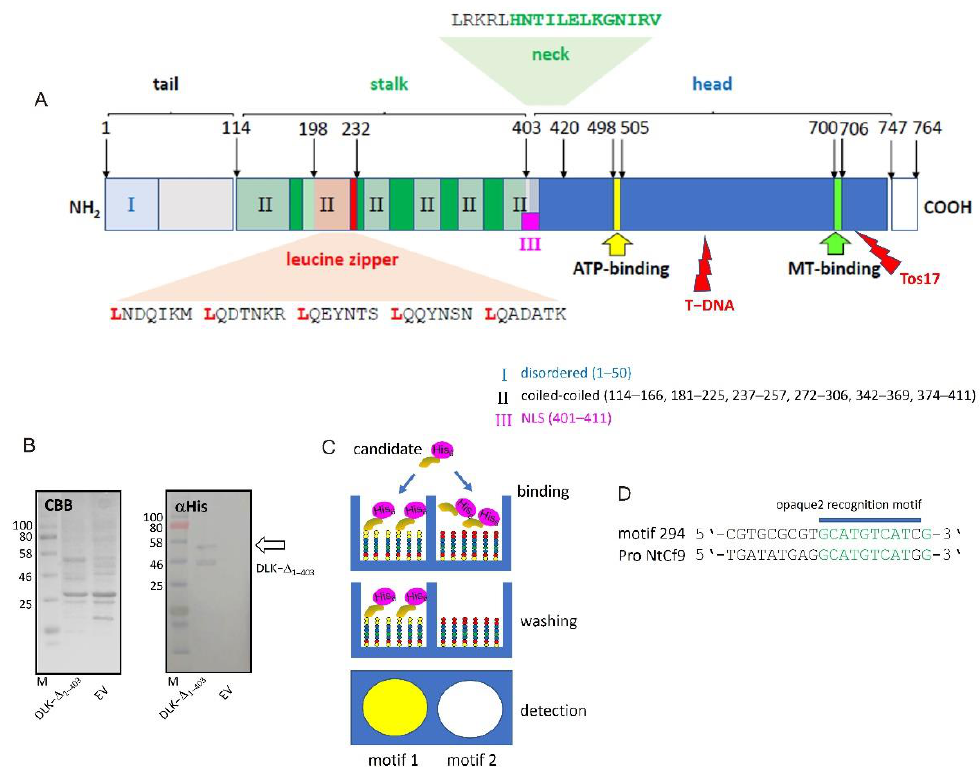
Figure 5. OsDLK qualifies as specific DNA binding protein. ( A ) Domain structure of OsDLK showing the position of the leucine zipper, the nuclear localisation signal (NLS), along with the neck region (the characteristic signature for minus-end-directed motors in bold), the C-terminal motor-head domain, and the ATP-binding and the MT-binding sites. The insertion sites for the mutant lines are given by red lightning bolts. T-DNA indicates the insertion of T-DNA in line 3A-07110 and Tos−17 is the insertion of the Tos−17 retrotransposon in line ND4501. ( B ) Recombinant expression of the N-terminal half (amino acids 1–403, DLK-Δ 1–403 ) of DLK versus control cells transformed with the empty vector (EV). The eluents of the Ni-agarose are shown after SDS-PAGE and either staining with Coomassie Brilliant Blue (CBB) or after Western Blotting and probing with αHis antibodies. The respective bands of the expected size are indicated by arrows. ( C ) Principle of DPI-ELISA screening for DNA motives recognised by a DNA-binding candidate protein. Arrays of oligonucleotide motifs coated in microtiter wells are incubated with the His-tagged recombinant candidate. Unbound protein is washed off and bound protein is detected by ELISA. ( D ) High-affinity candidate motif 294 containing an opaque2 recognition motif is found in the promoter of NtAvr9/Cf9.